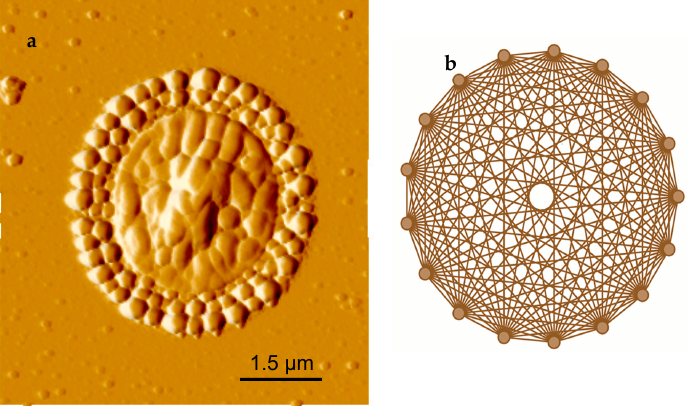
Figure 3. Comparison of the ring pattern to geometric design: ( a ) AFM image of a single protein ring pattern and ( b ) geometric n -simplex.